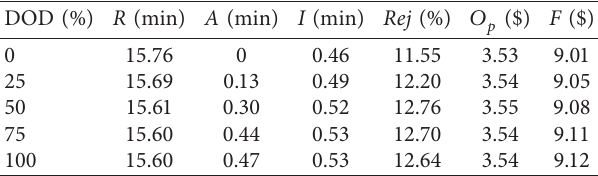
Table 4: Simulation results with different cancellation rates.